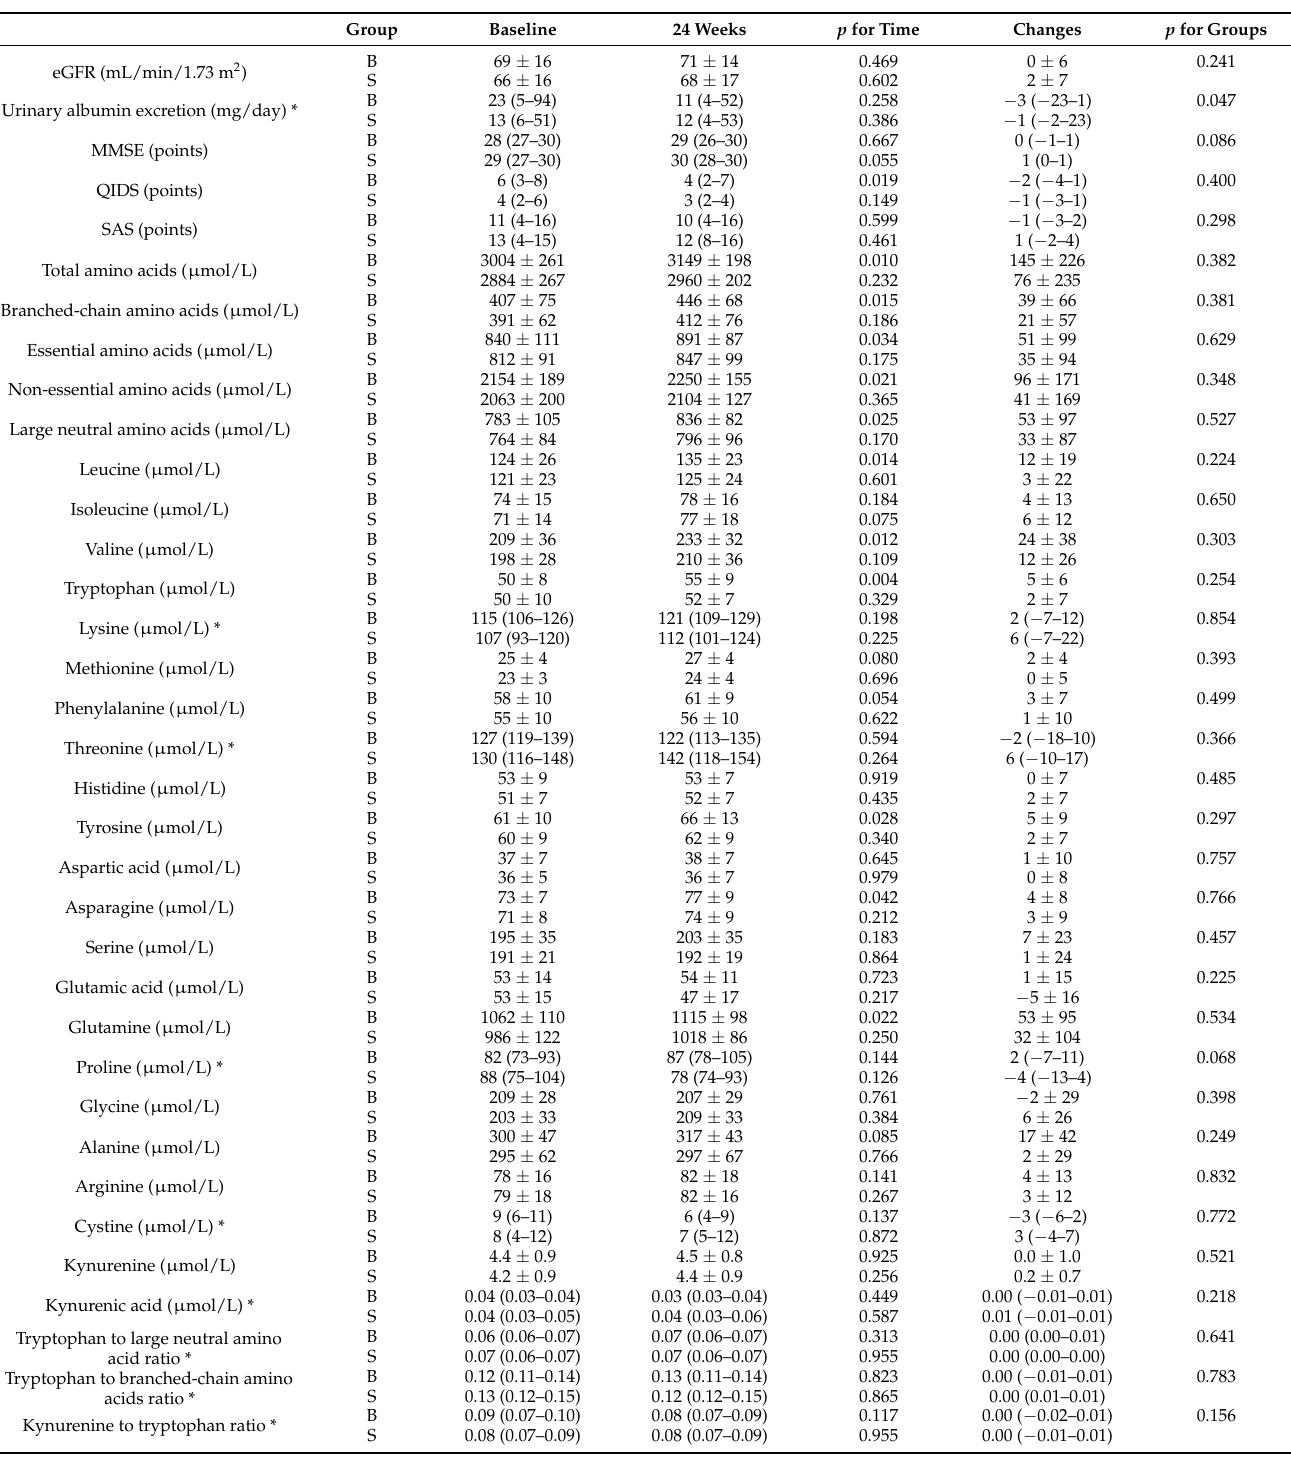
Table 4. Changes in renal function, neuropsychological performance, and amino acid and kynurenine metabolism during the intervention.